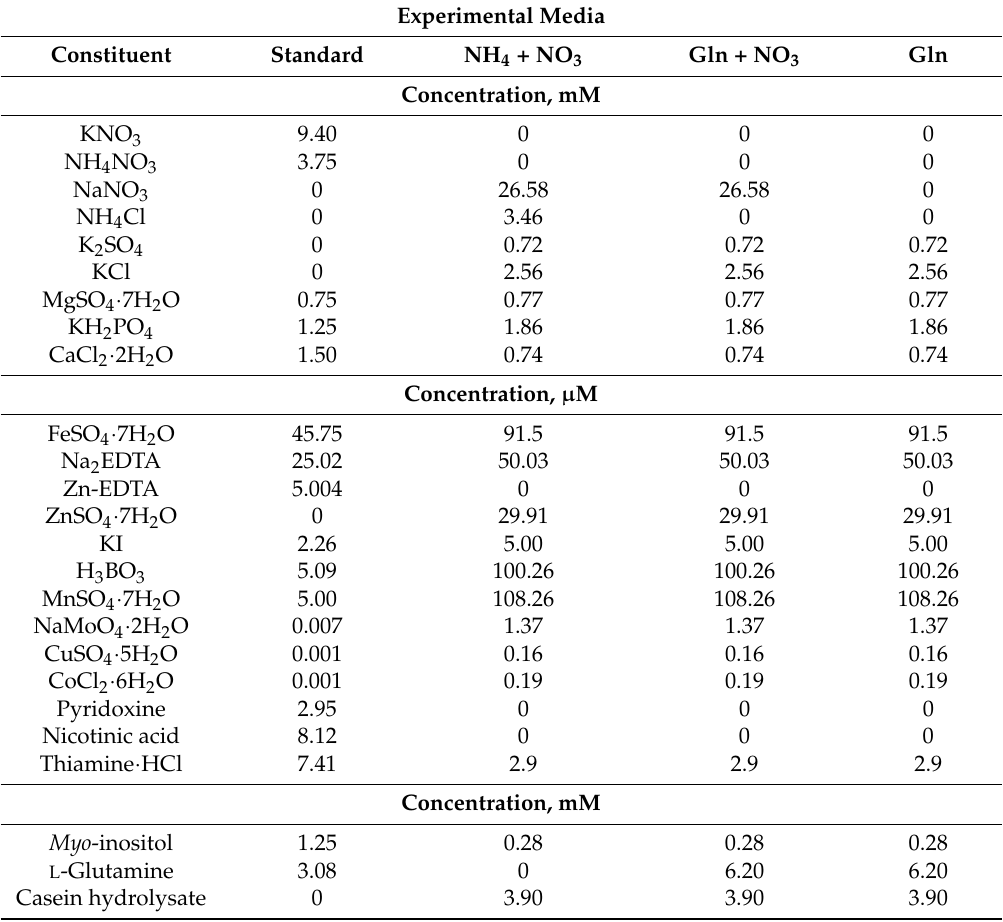
Table 1. Mineral, organic nitrogen and vitamin composition of the standard and experimental media for proliferation of PEMs. Sucrose (29.21 mM) and the growth regulators 2,4-D (10 µ M) and N6-benzylaminopurine 4.4 µ M were also included. Media were solidified with gelrite (3.5 g L − 1